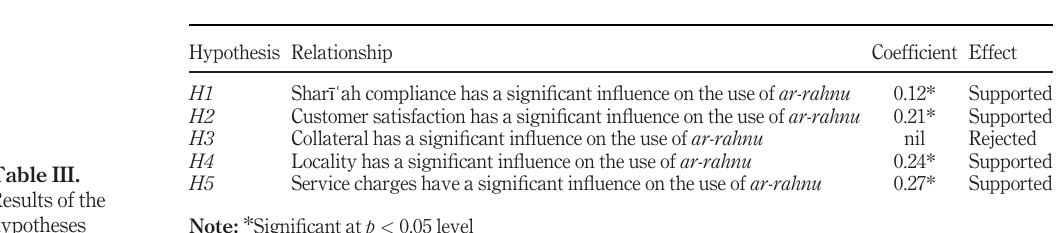
Table III. Results of